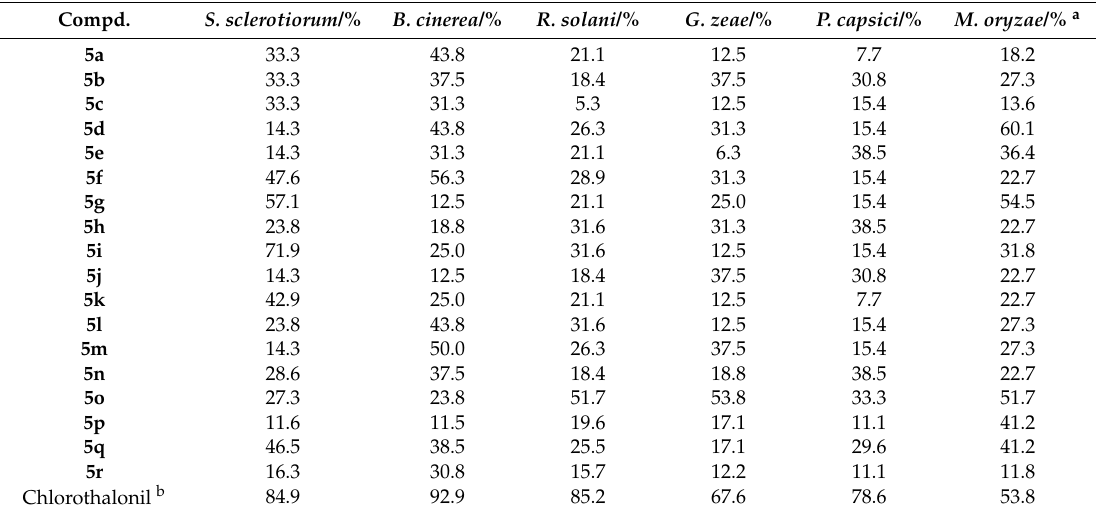
Table 2. Fungicidal activities of compounds 5a – r